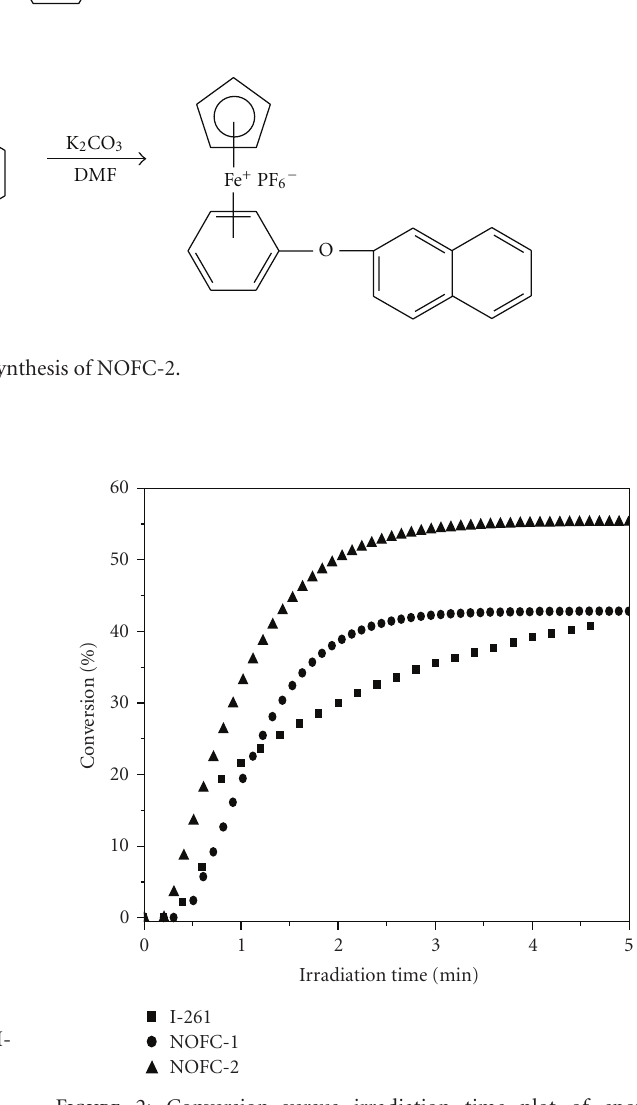
Figure 2: Conversion versus irradiation time plot of epoxy monomer ERL4221 initiated by 3.0 wt% photoinitiator (I = 80mW/cm 2